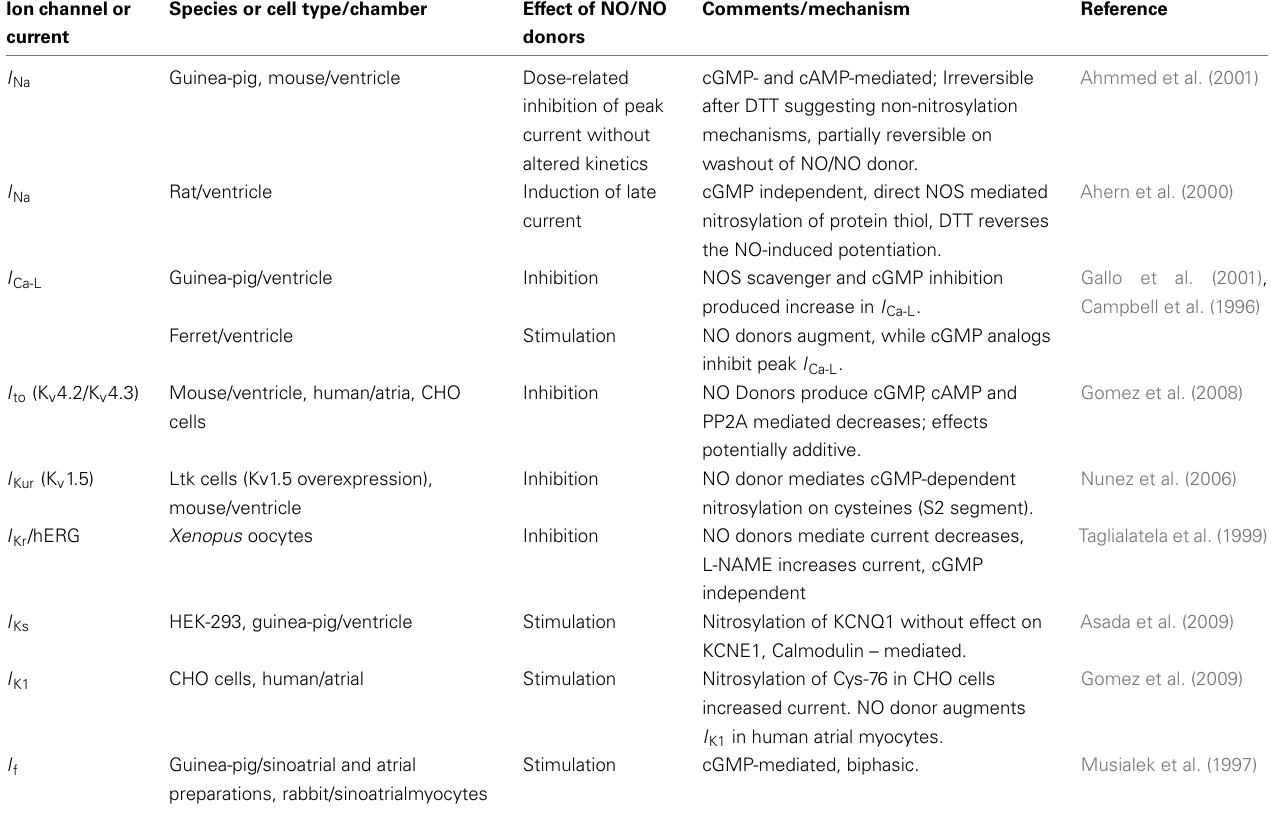
Table 1 | Electrophysiologic effects of NO.